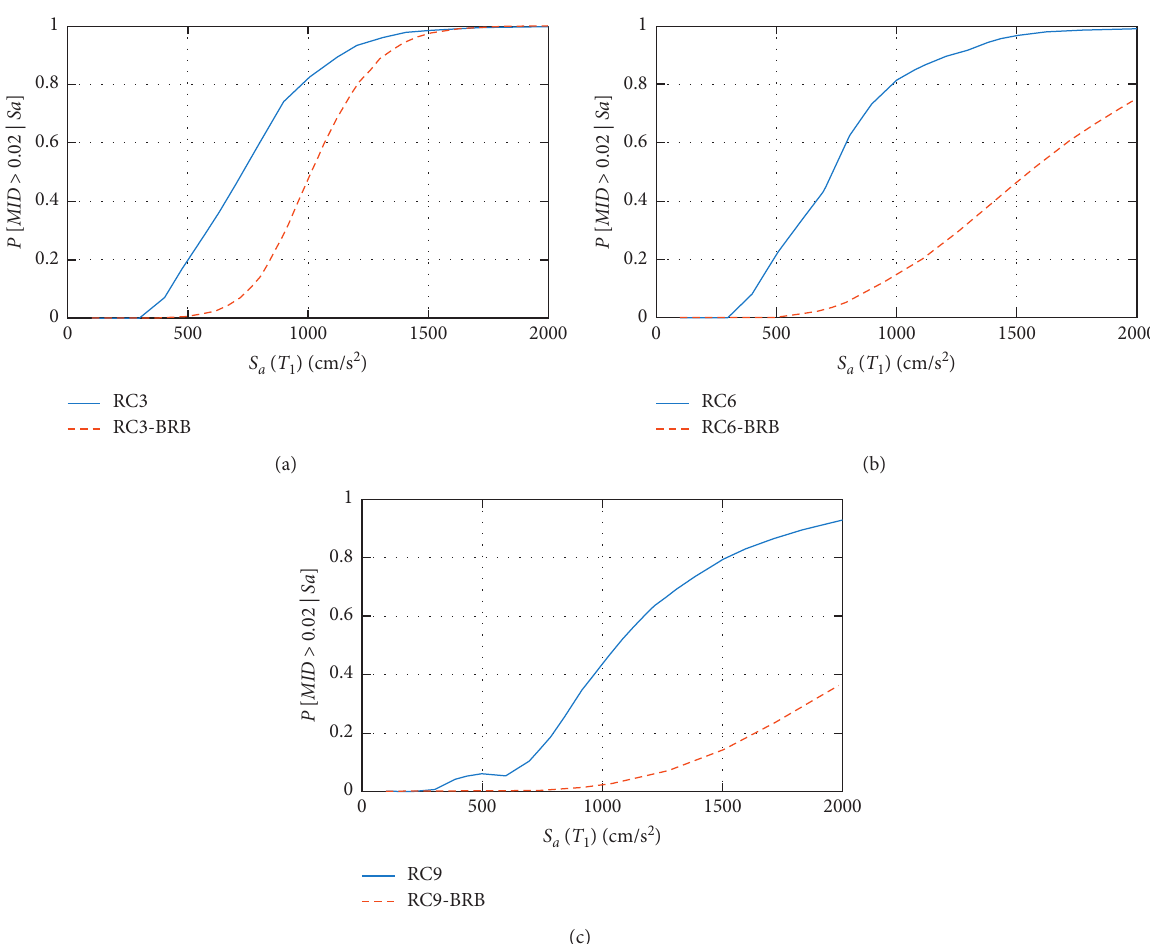
Figure 7: Fragility curves for maximum interstory drift and all the studied buildings.